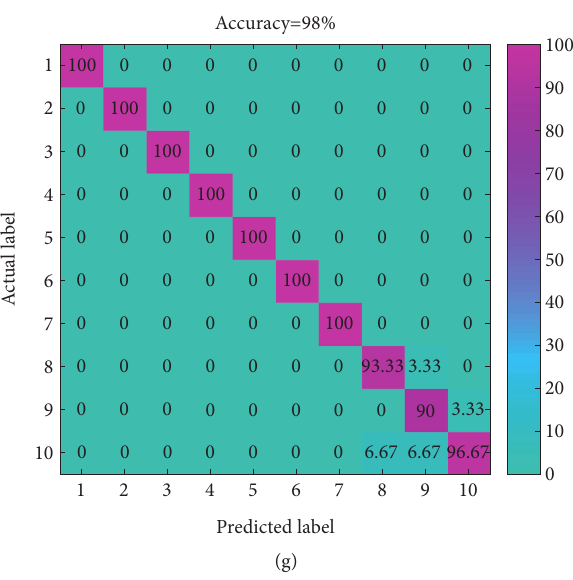
Figure 13: The confusion matrix of the seven feature extraction